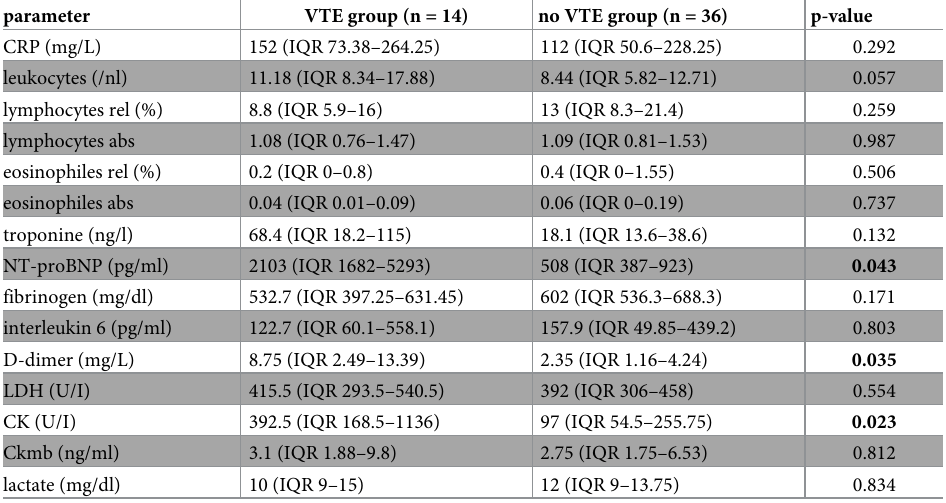
Table 6. Differences between VTE vs. no VTE regarding laboratory